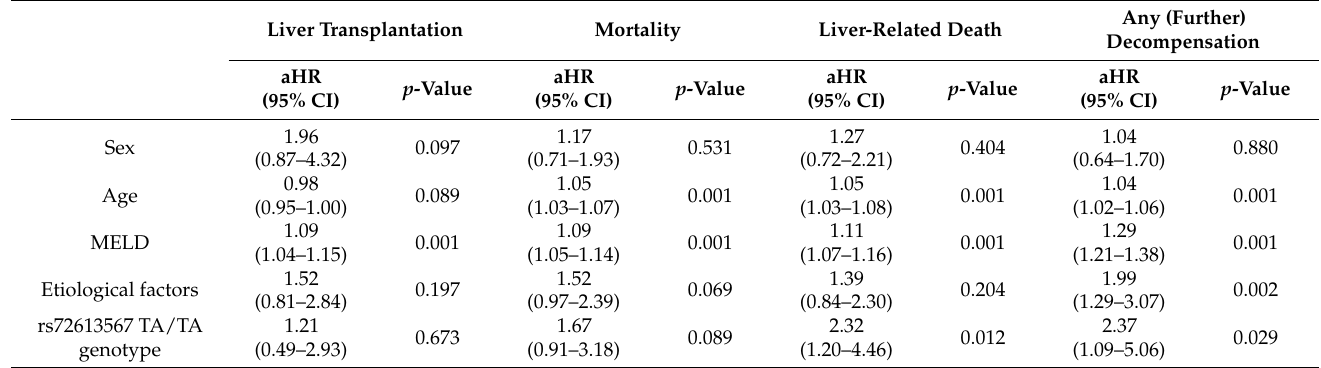
MELD: Model for End-Stage Liver Disease; etiological factors: relapse in alcohol intake or active viral